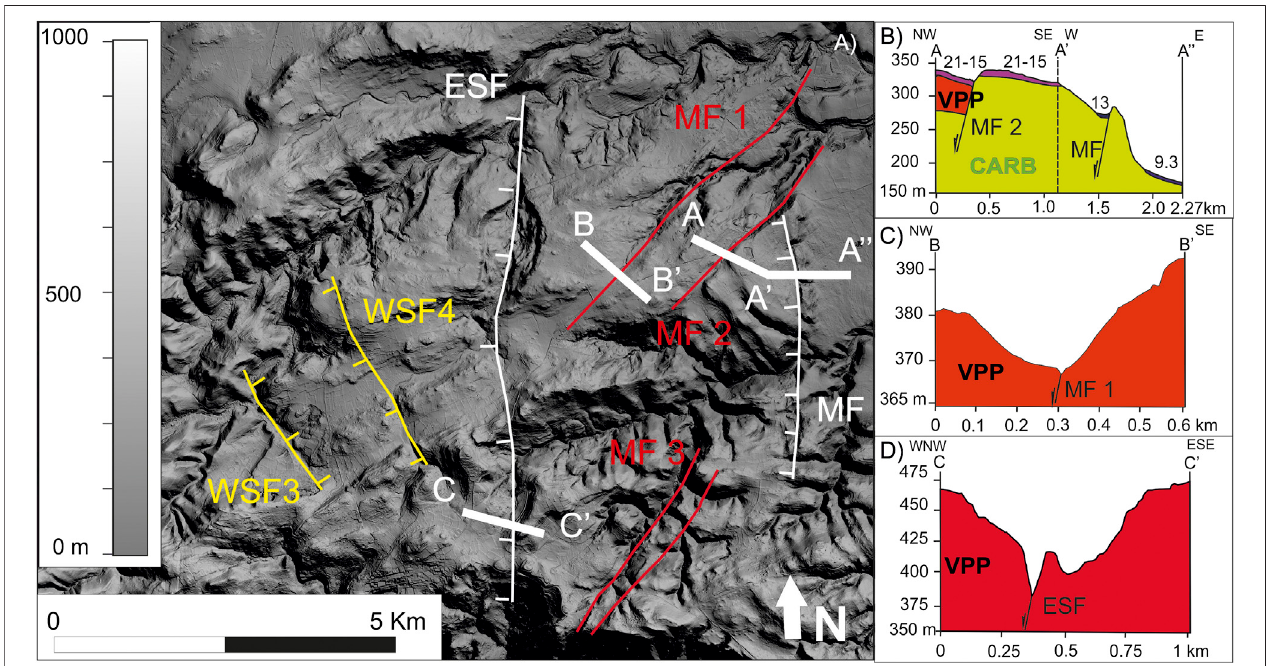
FIGURE 7 | (A) A detail of DEM west of Melilli town showing the morphological scarps created by MF, MF1, MF2 and ESF ( fi gure location in Figure 6B ). (B) Pro fi le acrossMF2 and MF showing the dislocation ofthe marine terraces(see Figure 2B for terrace location). (C) Pro fi le across MF1 showing the asymmetry ofthe valley with the rejuvenation of the valley pro fi le side that lies at the fault footwall. (D) Pro fi le showing ESF that displaces a valley and causes the shifting of a river course westwards.